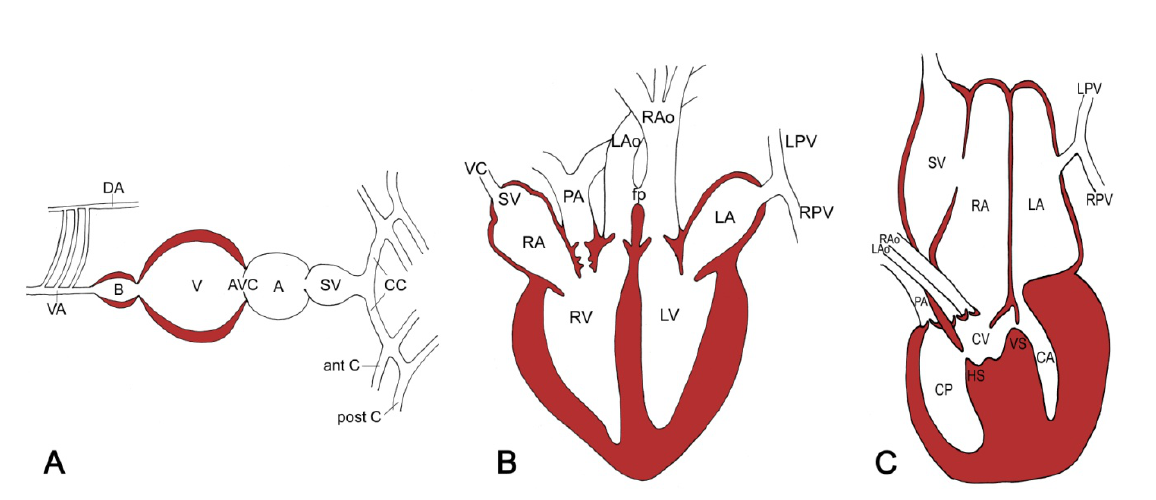
Figure 2: Schematic drawings of the hearts of (A) zebrafish, (B) crocodiles and (C) non- crocodilian reptiles. A, atrium; ant C, anterior cardinal; AVC, atrioventricular canal; B, bulbus; CA, cavum arteriosum; CC, common cardinal; DA, dorsal aorta; fp, foramen of panizza; LA, left atrium; LAo, left aorta; LPV, left pulmonary vein; LV, left ventricle; PA, pulmonary artery; post C, posterior cardinal; RA, right atrium; RAo, right aorta; RPV, right pulmonary vein; RV, right ventricle; SV, sinus venosus; V, ventricle; VA, ventral aorta; VC, vena